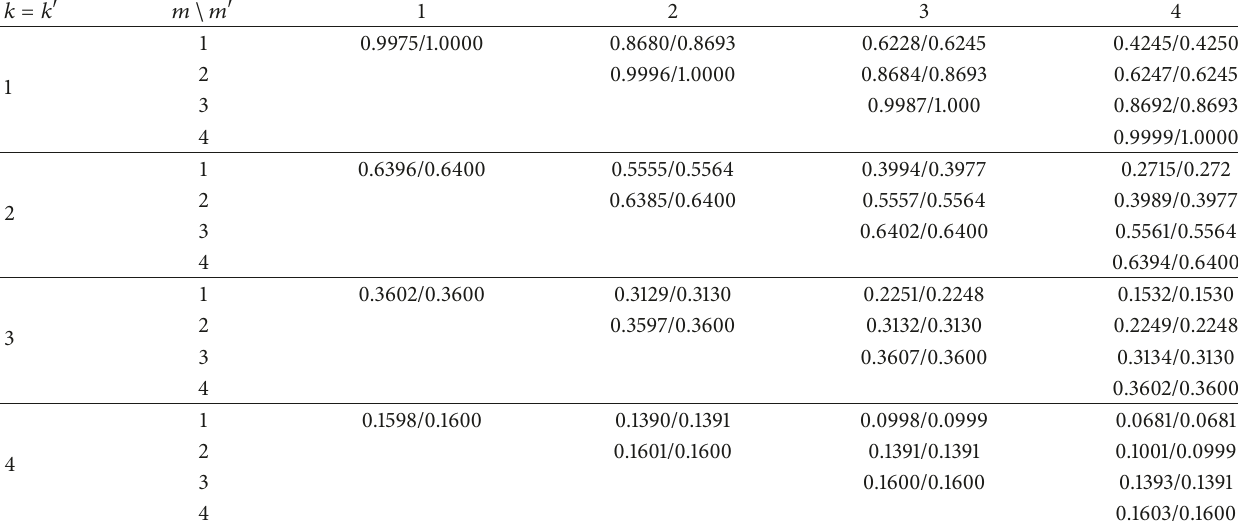
Table 1: Delayed path correlation in terms of |𝛾| (the values in the table are “generated/expected”).